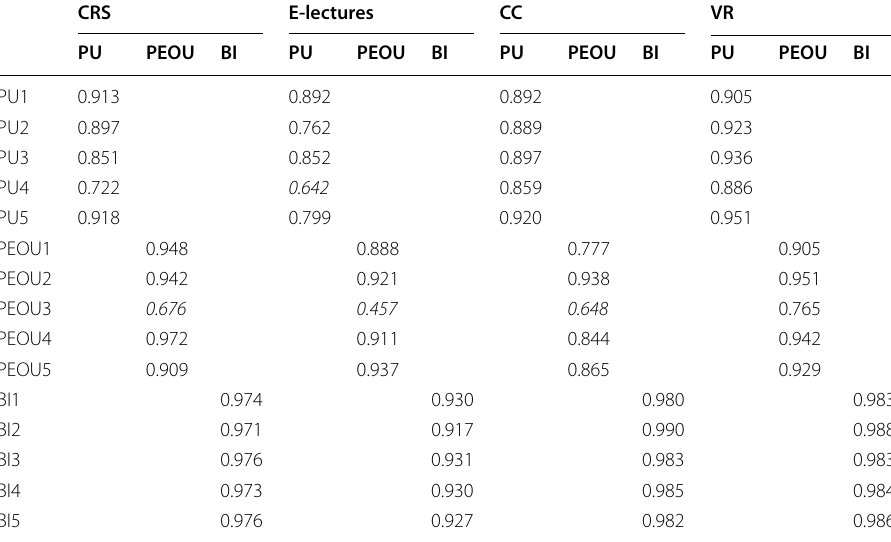
Table 1 Outer standardized loadings of the measurement models of each tool’s technology acceptance (CRS, e-lectures, CC, and VR)